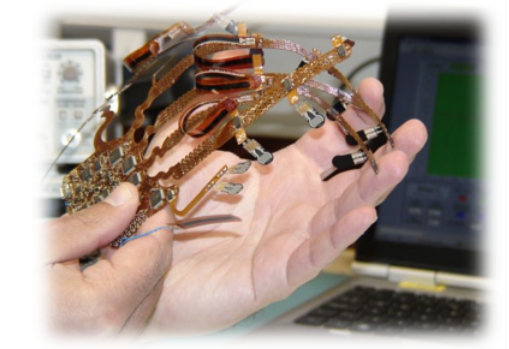
Figure 16. UU/Tyndall accelerometers [41].